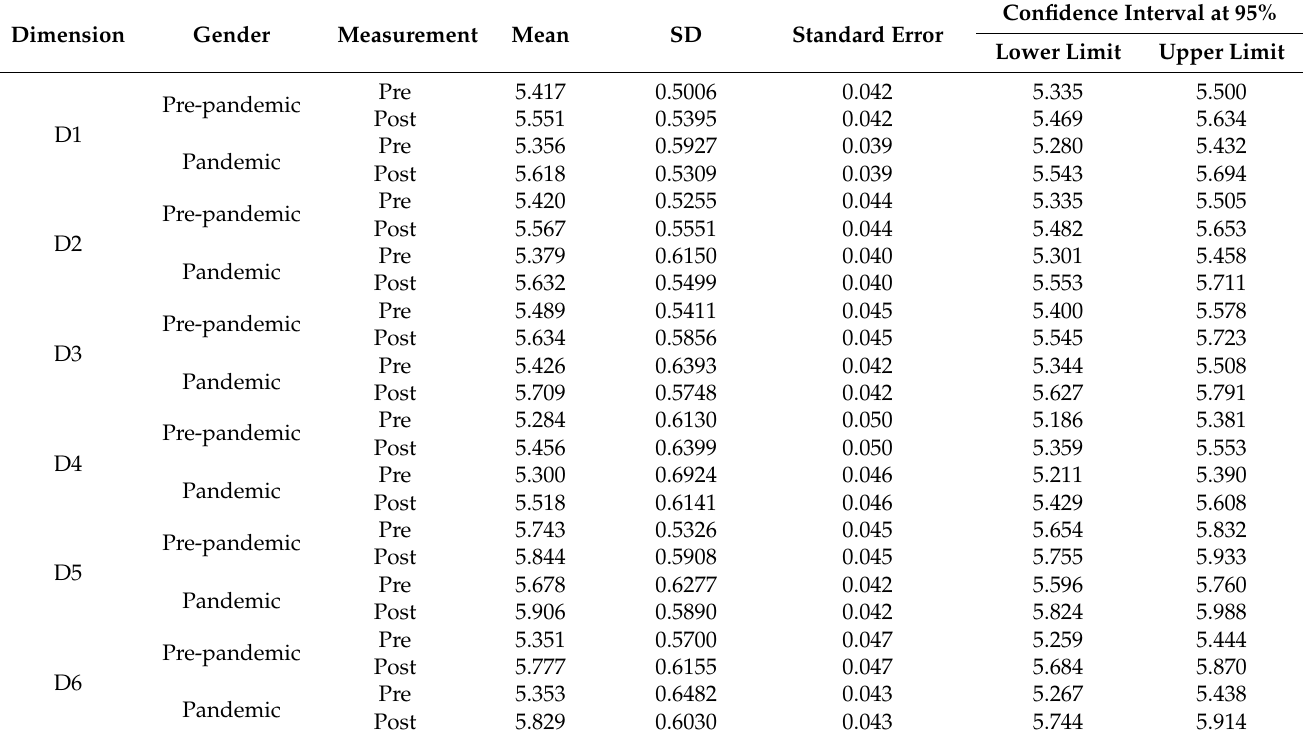
Table 5. Descriptive data of the variables initial–final values vs. pandemic.